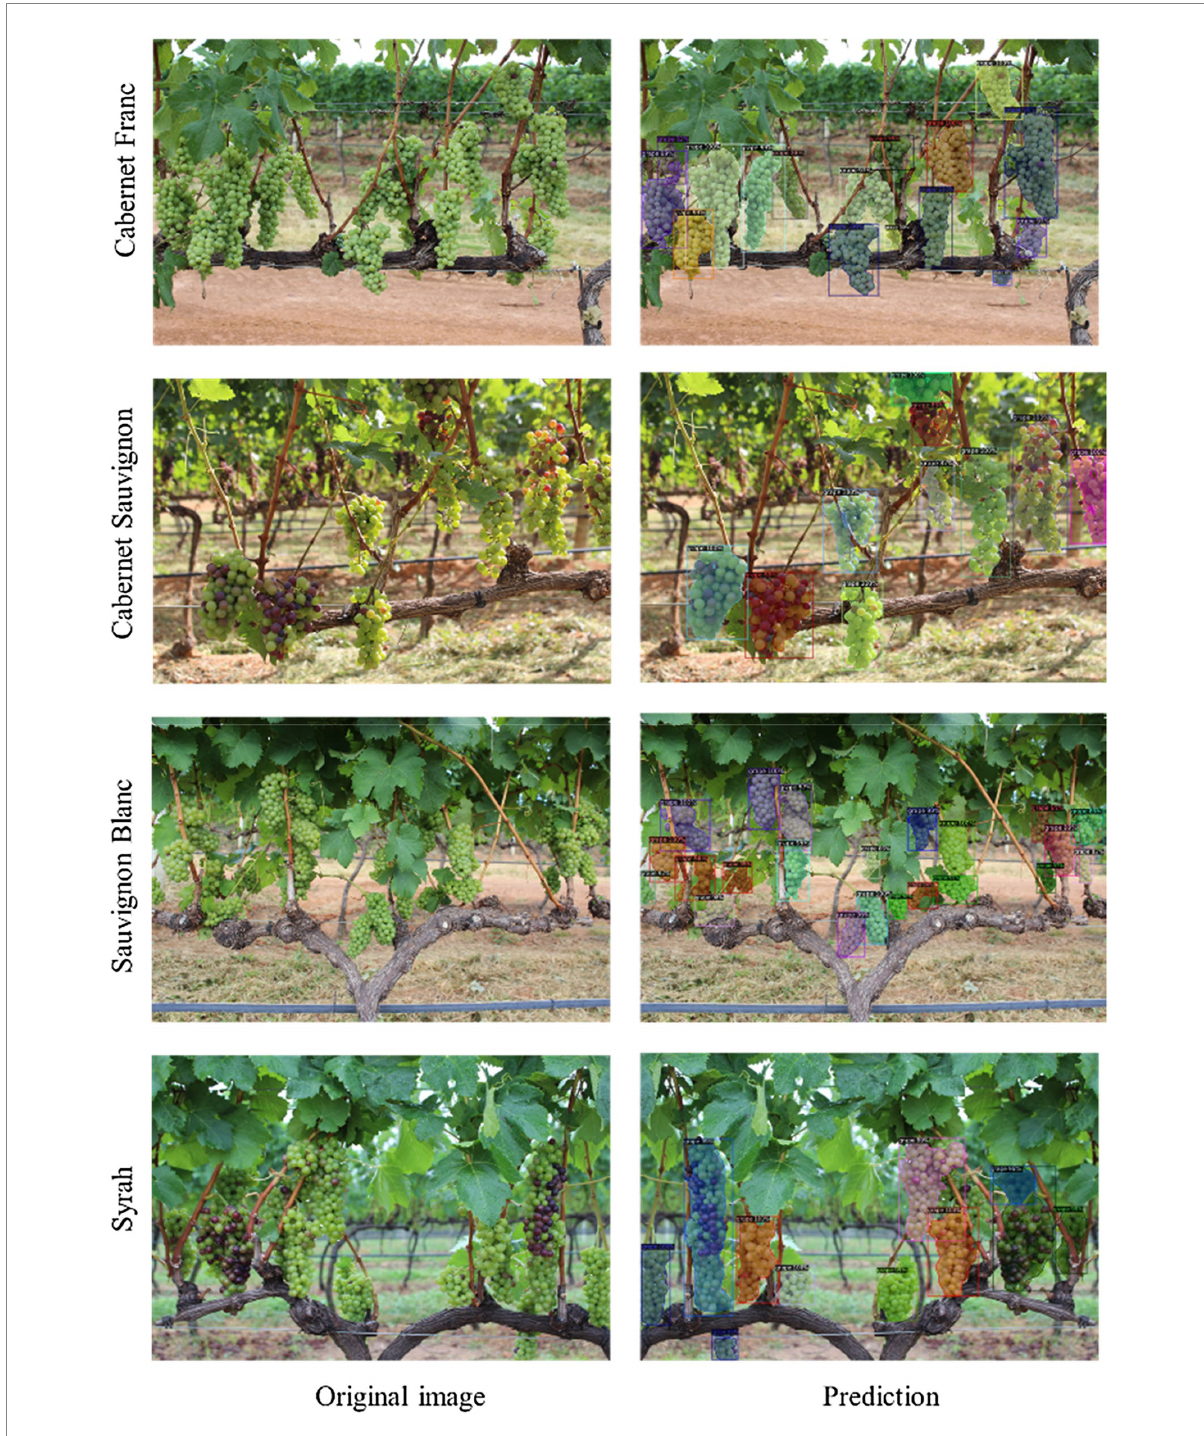
FIGURE 12 Example results of the improved Mask R-CNN model for different grape